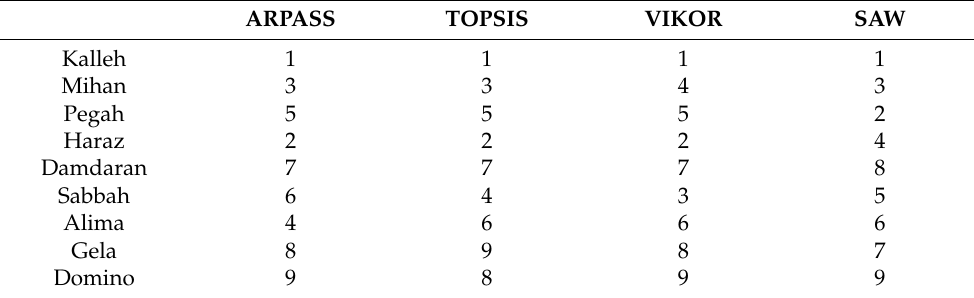
Table 17. The ranking results in ARPASS, TOPSIS, SAW, and VIKOR